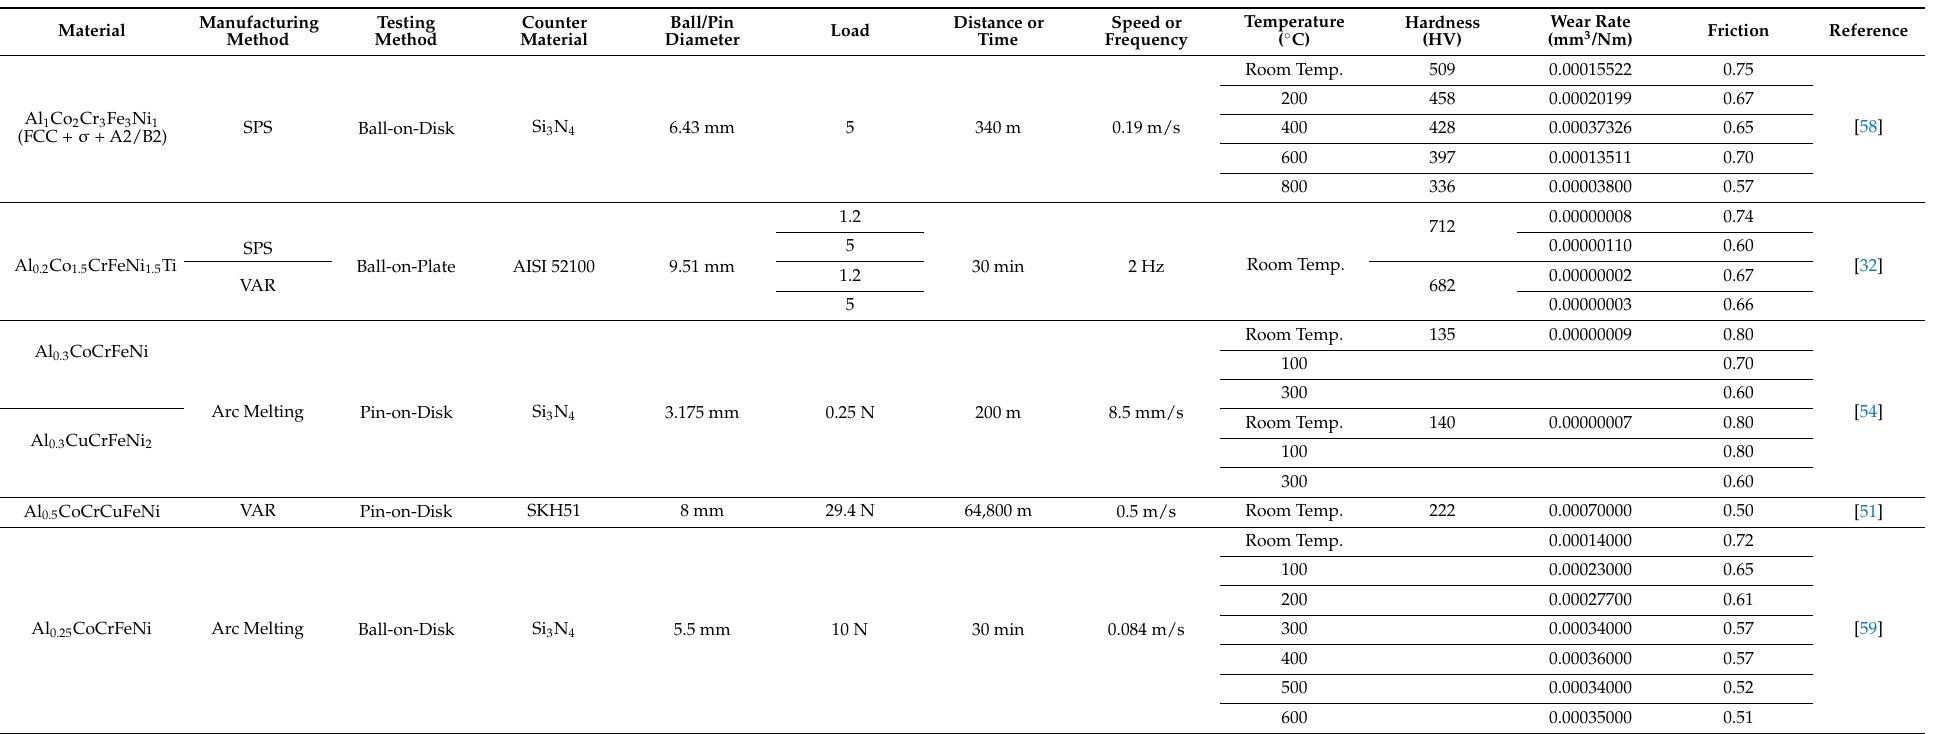
Table 2. FCC phase group test procedures and tribological